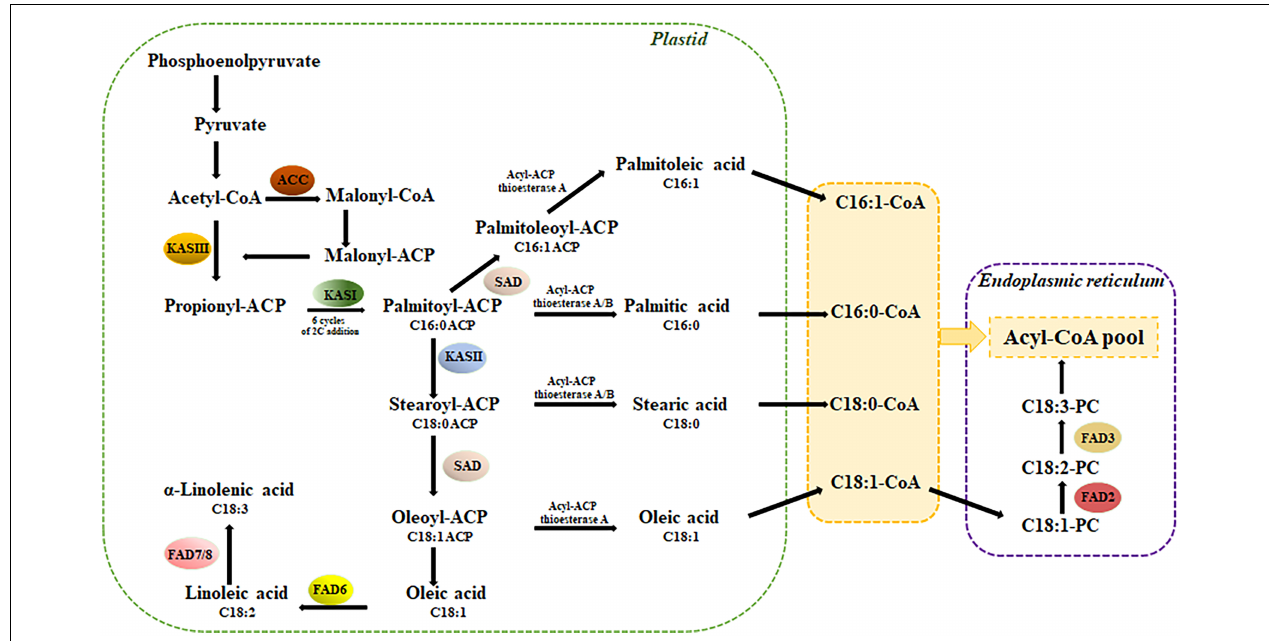
FIGURE 1 | Simplified biosynthetic pathway of fatty acids in plants (based on Dar et al., 2017): ACC, acetyl-CoA carboxylase; KAS, ketoacyl-ACP synthase; SAD, stearoyl-ACP desaturase; FAD, fatty acid desaturase; PC, phosphatidylcholine.